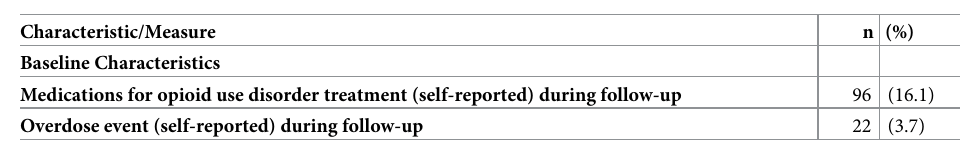
Table 2. Multivariable continuation ratio regression assessing the association between changes in prescribed opioid dose and use frequency of heroin and non-pre- scribed opioid pain relievers.